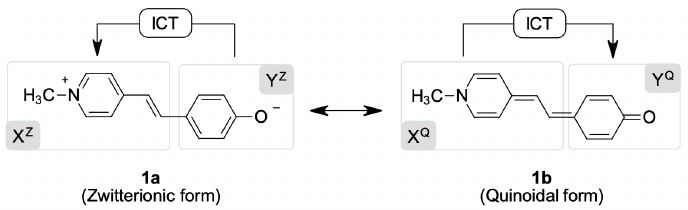
Figure 2. The two mesomeric limits of Brooker’s merocyanine 1 [21], an inverted solvatochromic dye. Superscripts Z and Q refer to the zwitterionic and quinoidal forms, respectively. ICT = internal charge transfer.